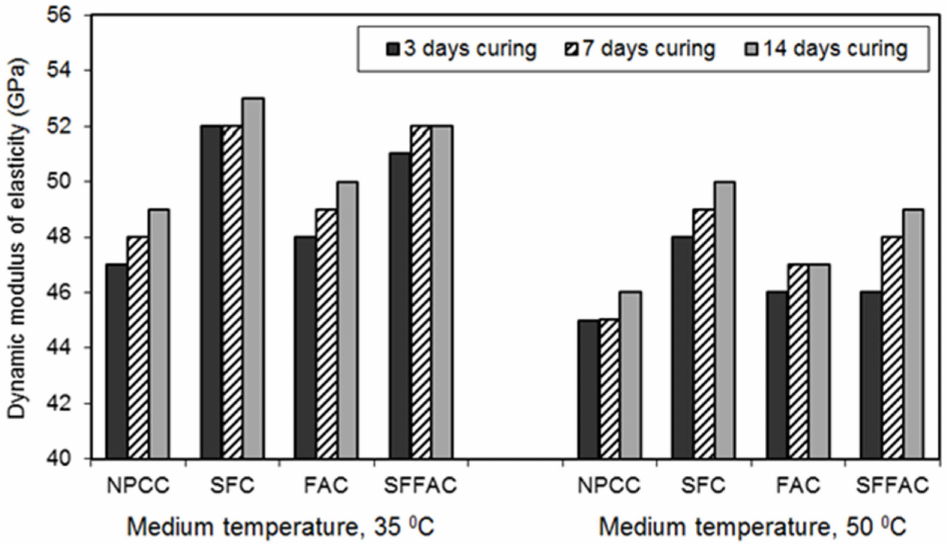
Figure 7. The 91-day dynamic modulus of elasticity (GPa) of different types of concrete transferred after 3, 7 and 14 days of water curing at 20 ˝ C followed by exposure to two medium temperatures of 35 ˝ C and 50 ˝